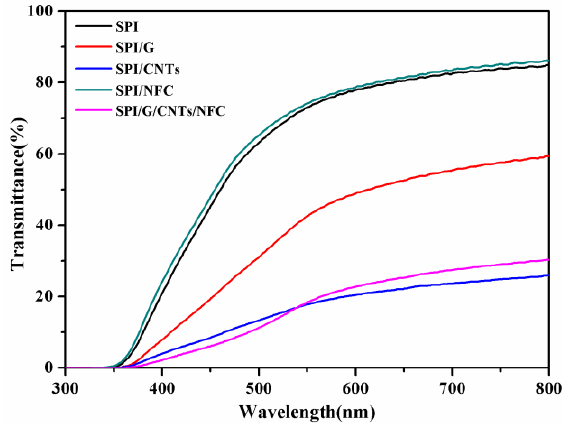
Figure 5. Ultraviolet – visible (UV – vis) spectroscopy of SPI film and SPI-based nanocomposites.